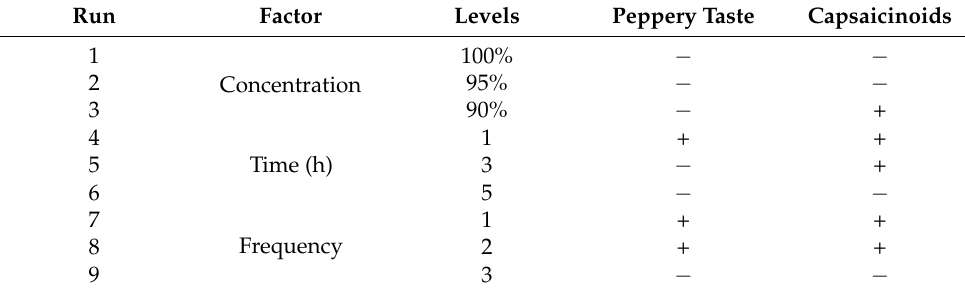
Table 3. Extracting factors and results of